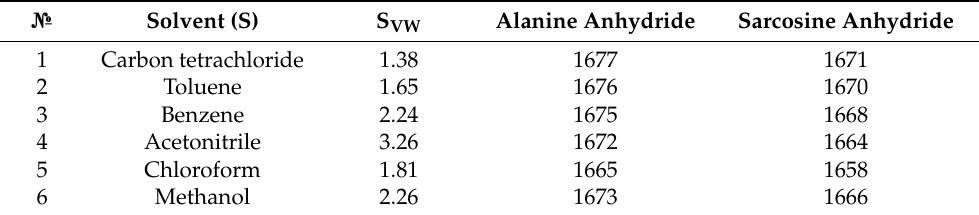
Table 3. Absorption frequency of C=O group of alanine (AA) and sarcosine (SA) anhydrides in